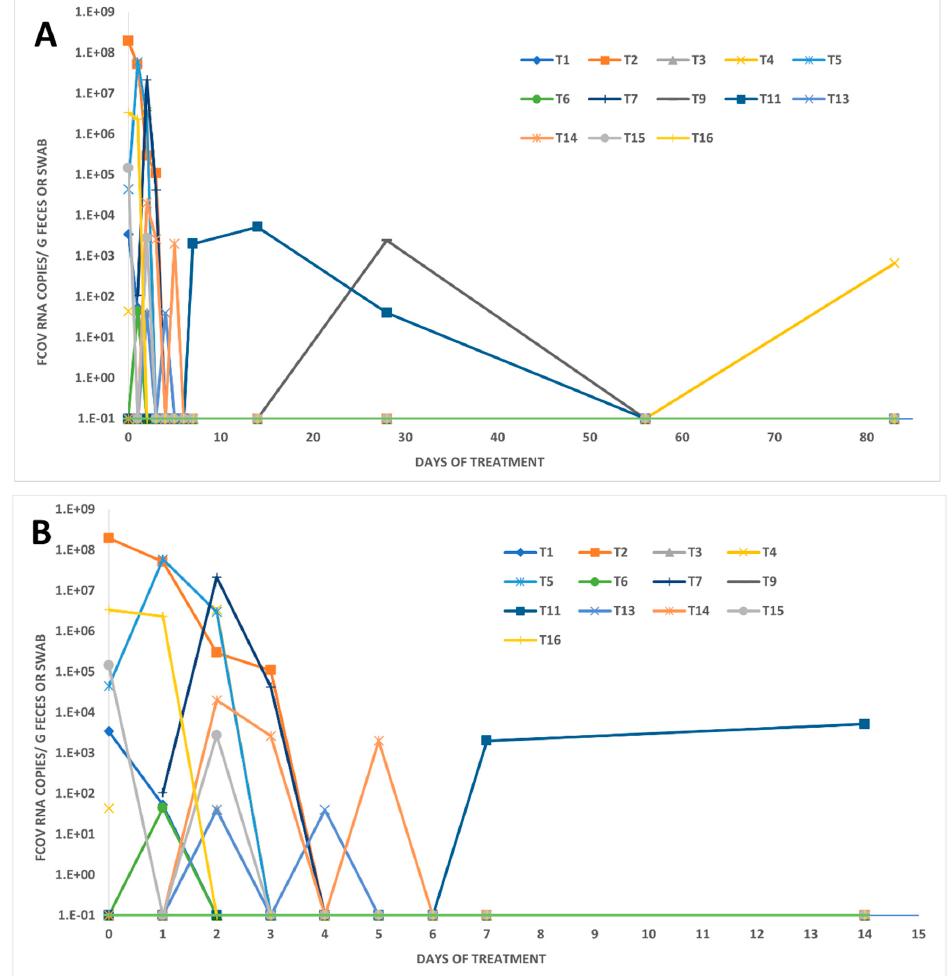
Figure 2. Viral RNA loads in voided fecal samples and fecal swabs of FIP treated cats (T1–T18). Fecal samples were collected from the 18 treated FIP cats ( A ): on days 0, 1, 2, 3, 4, 5, 6, 7, 14, 28, 56, and 83;